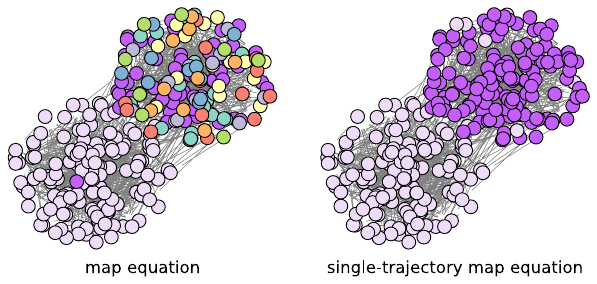
Figure 1. Community detection based on the map equation and the single-trajectory map equation applied to a synthetic network. The nodes in the same colour belong to the same module. See “Experiments” section for details.